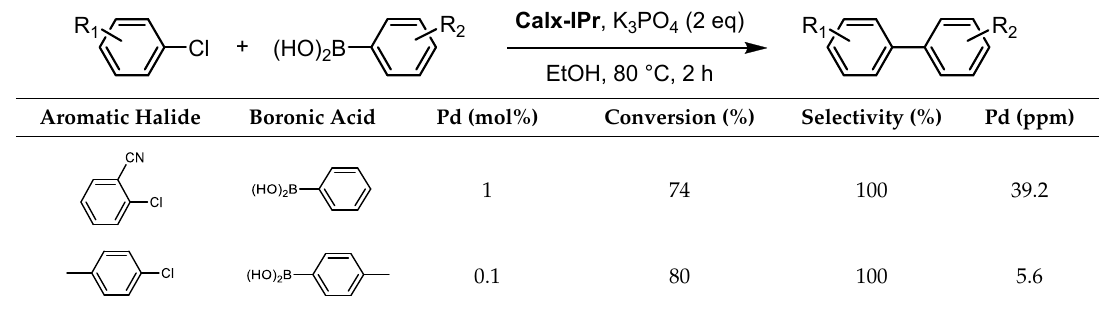
Table 5. ICP-MS analysis of two Suzuki–Miyaura coupling products.